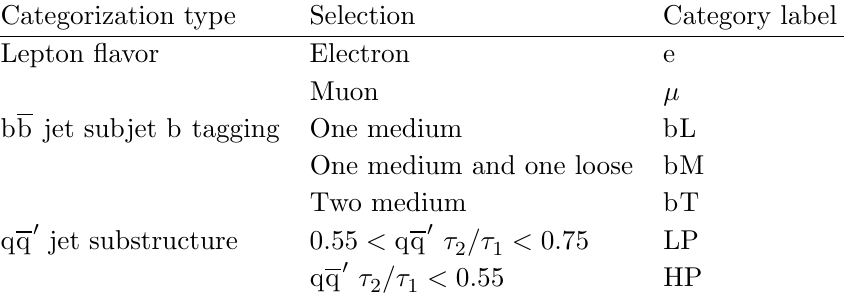
Table 1 . Event categorization and corresponding category labels. All combinations of the two lepton (cid:13)avor, three bb jet subjet b tagging, and two qq 0 jet substructure selections are used to form 12 independent event categories. For the bb jet subjet b tagging type, \medium" refers to the subjets that pass the medium b tagging operating point and \loose" refers to those that pass the loose, but not the medium, operating